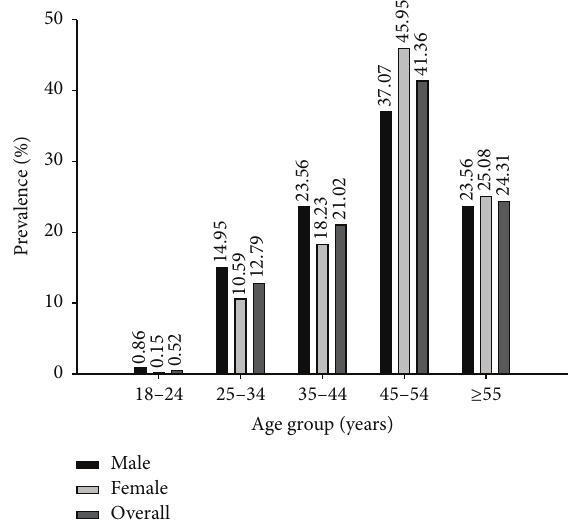
Figure 4: Prevalence of metabolic syndrome in different age groups.